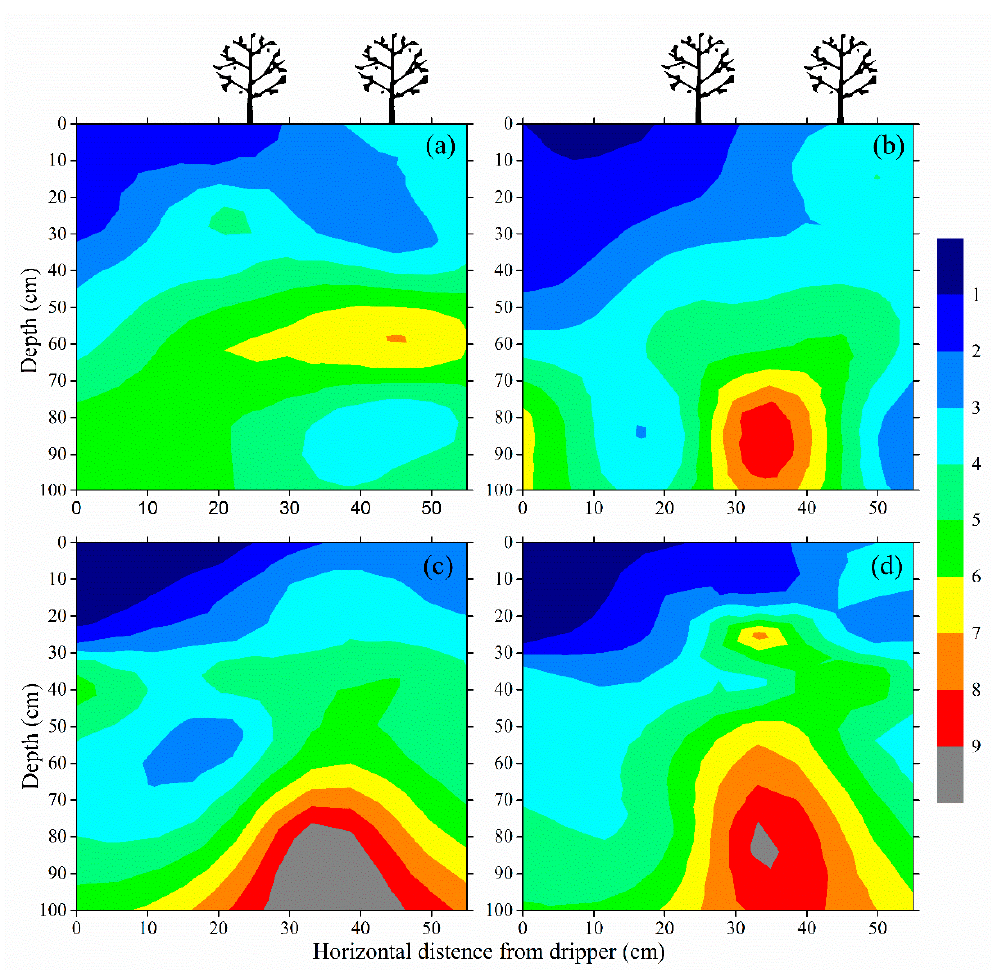
Figure 7. Vertical distribution of soil salinity (g kg –1 ) under mulched drip irrigation on ( a ) 20 June, ( b ) 23 June, ( c ) 30 June, ( d ) 8 July 2016.